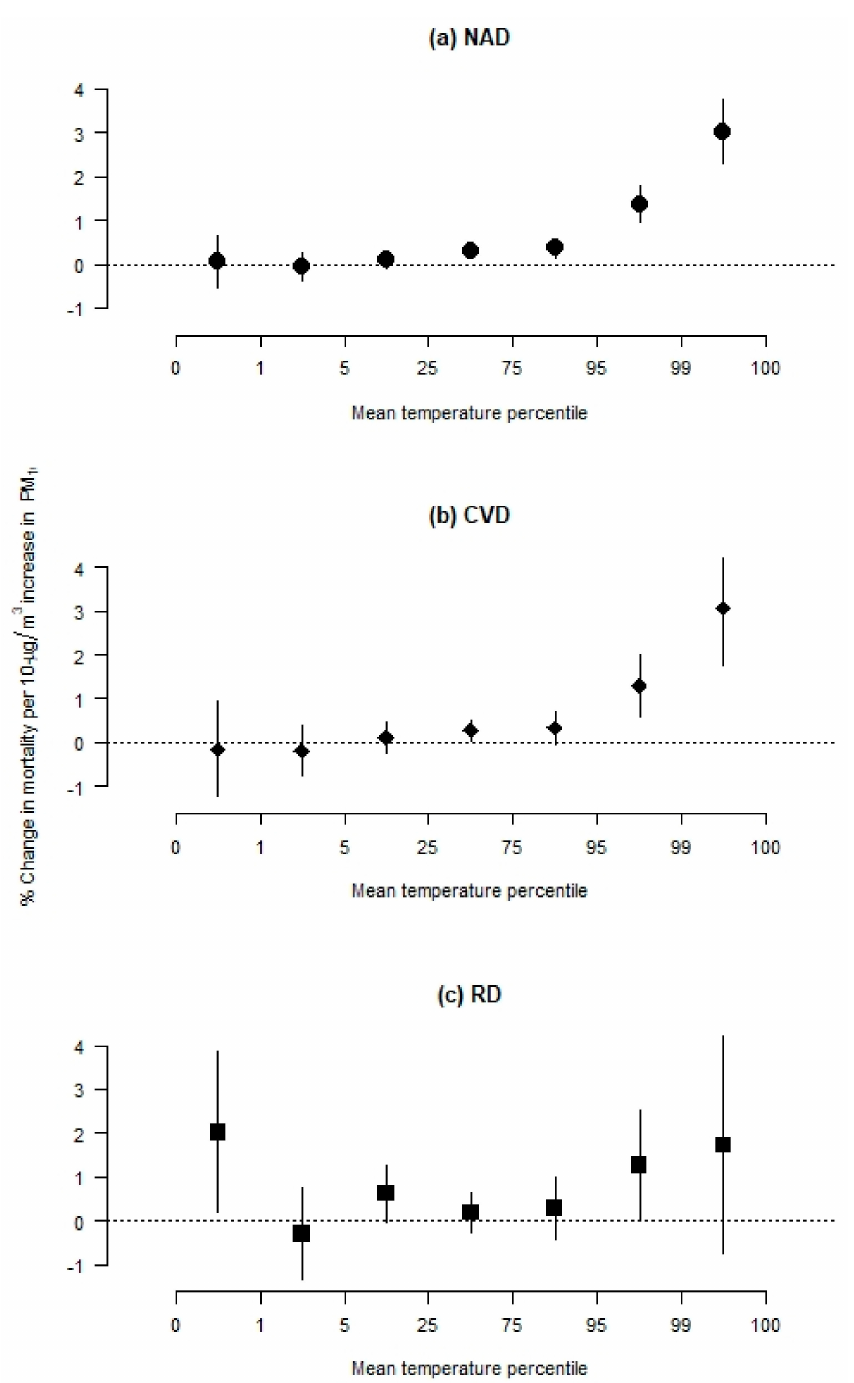
Figure 4. Percent changes in ( a ) non-accidental death (NAD), ( b ) cardiovascular disease (CVD) mortality, and ( c ) respiratory disease (RD) mortality in elderly Seoul residents, with a 95% confidence interval, for a 10 µ g / m 3 increment in PM 10 , by daily mean temperature percentile ( < 1st, 1st to < 5th, 5th to < 25th, 25th to < 75th, 75th to < 95th, 95th to < 99th, and ≥ 99th percentiles) at MA03 (the moving average for the current day and the previous 3